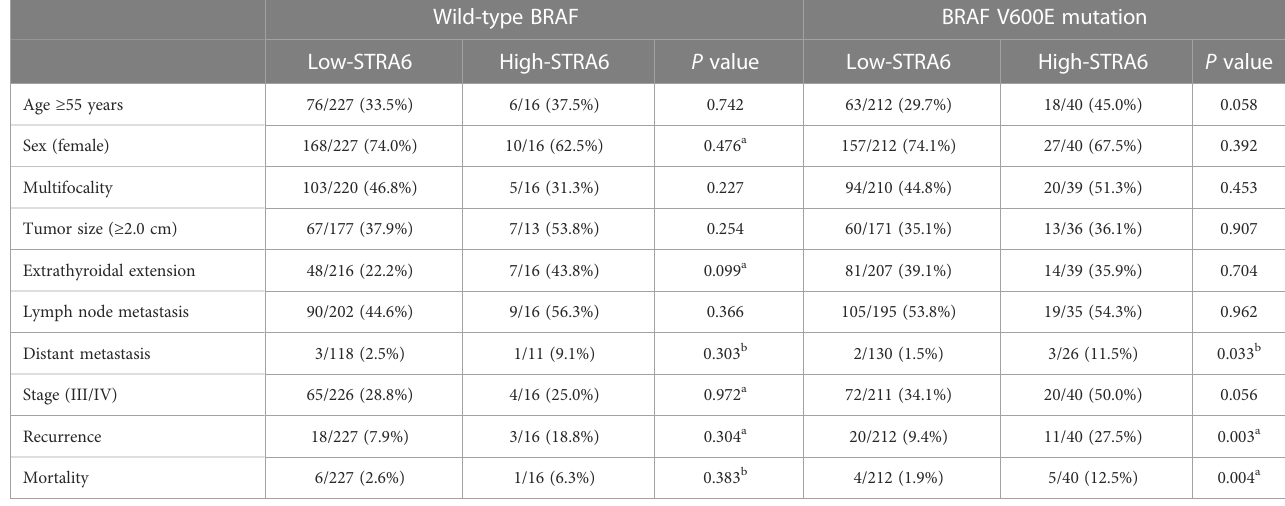
TABLE 2 Correlation between STRA6 expression and clinicopathological characteristics of PTC in the TCGA cohort based on the BRAF genotypes.